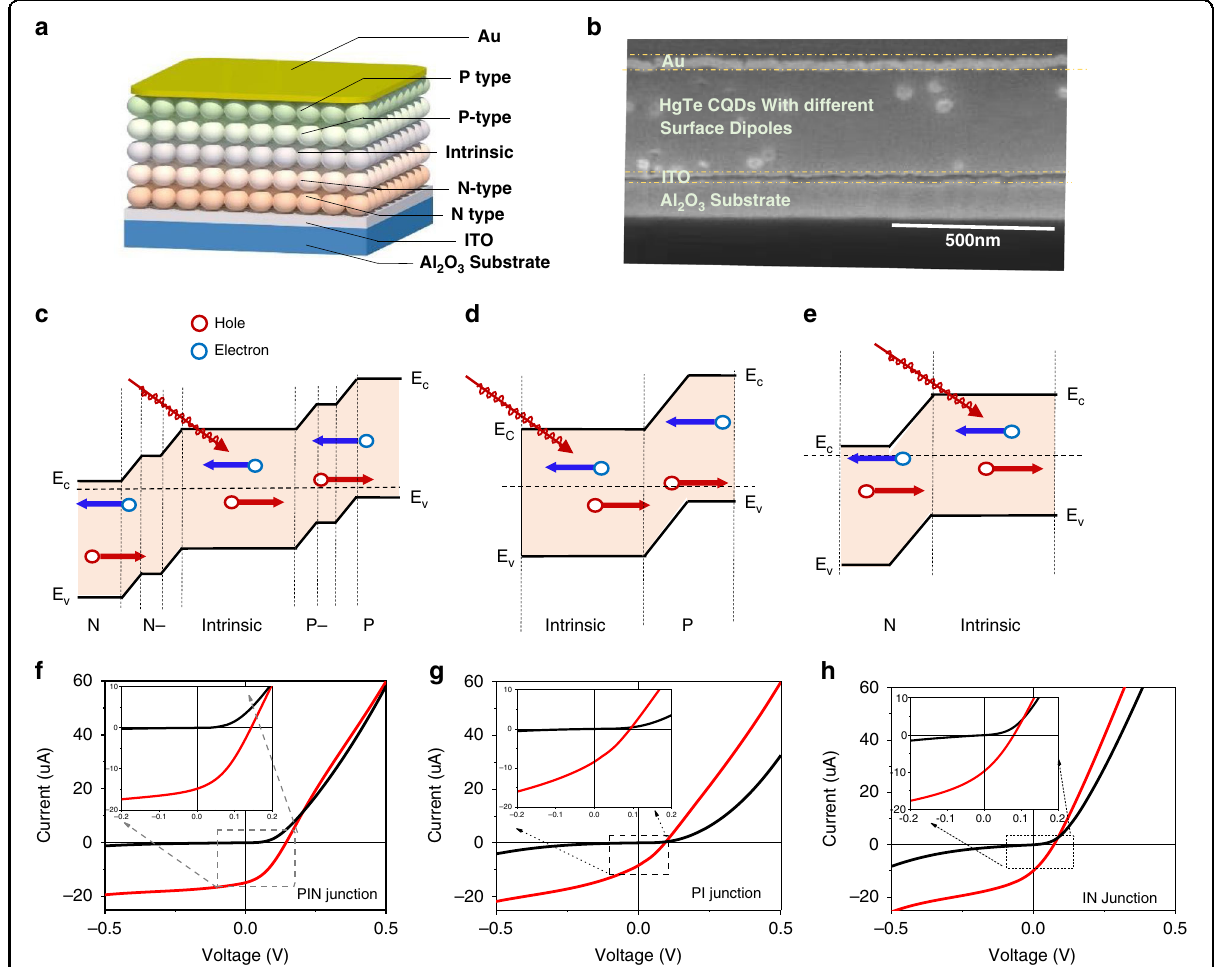
Fig. 2 CQD photodiodes. a Schematic diagram of high mobility CQD homojunction photodiode. b SEM of high mobility CQD homojunction photodiode cross-section. c – e Energy diagram of high mobility PIN gradient, PI, and IN homojunction, respectively. f – h I-V curve characterization on high mobility PIN gradient, PI, and IN homojunction devices with the insert graph zoom in the near zero bias part at 80 K,